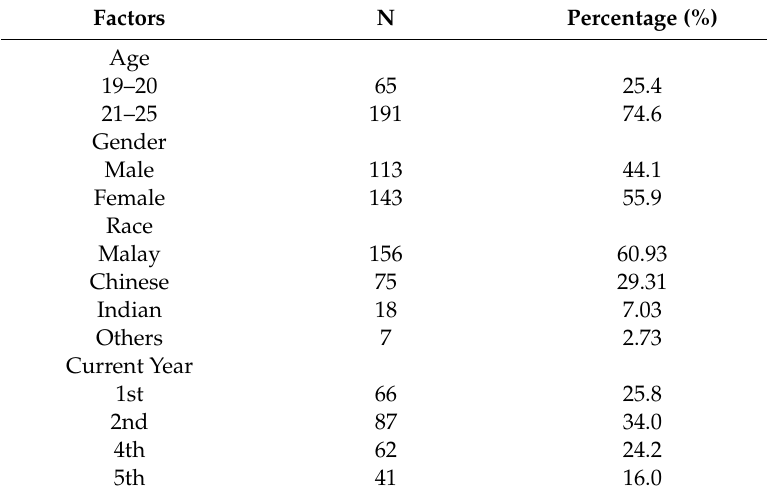
Table 2. Colonization of S. aureus on neckties, headscarves, and ID badges ( n = 433). The Colonization of Staphylococcus Attires